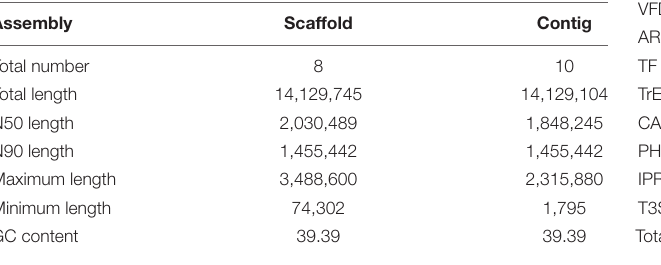
TABLE 2 | The details of genome assembly statistics for C. oleophila .